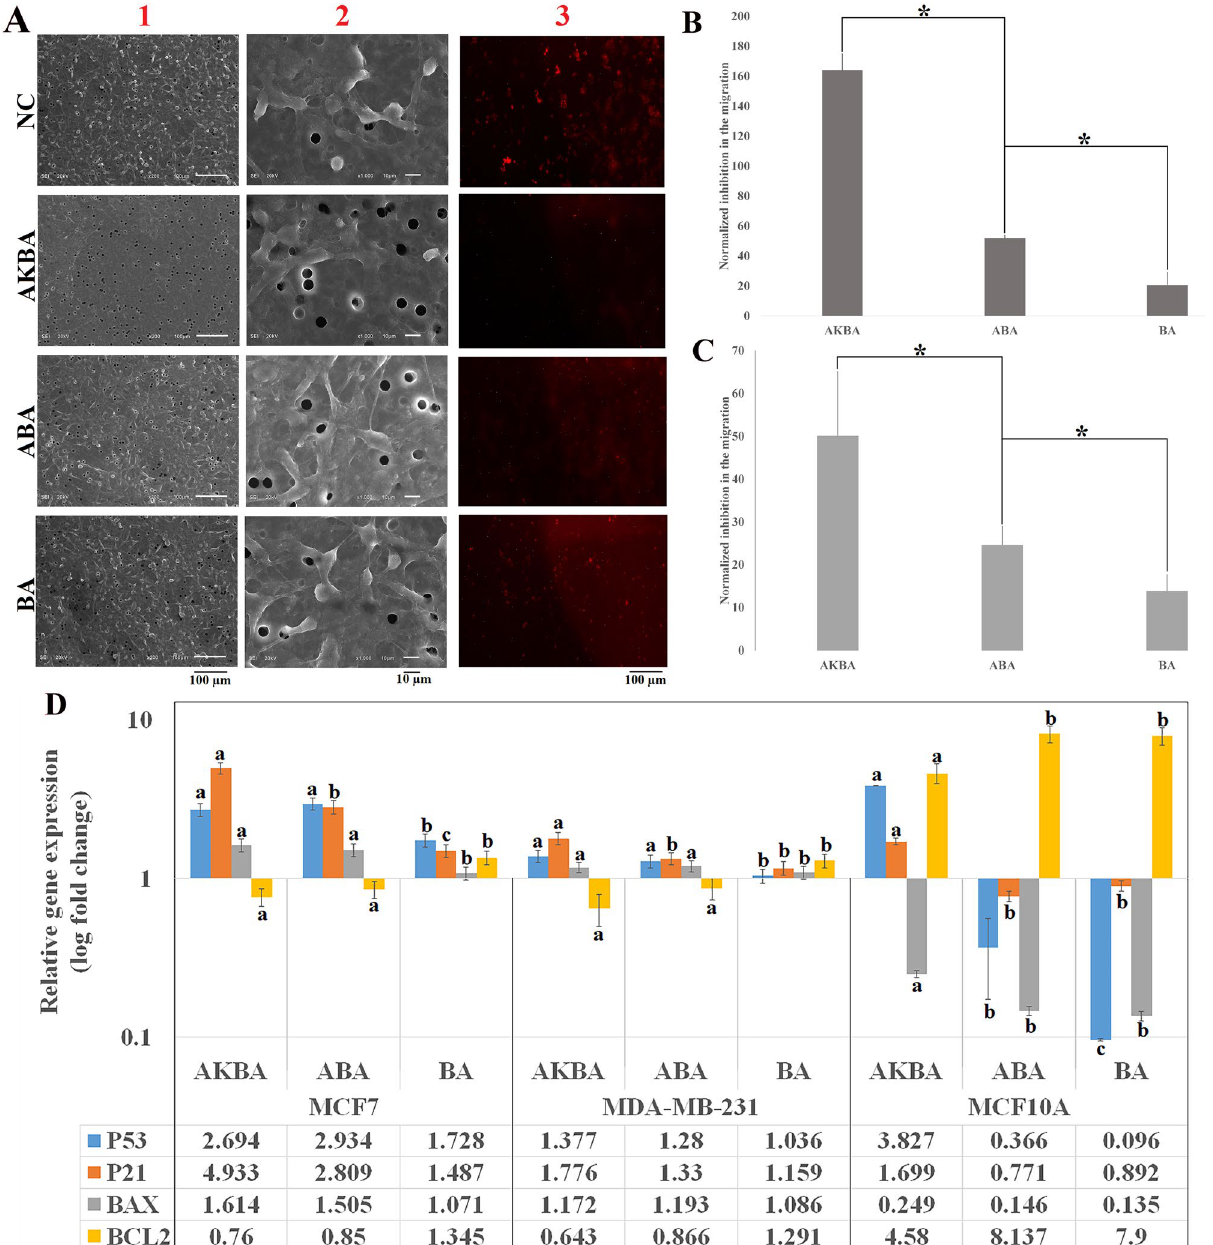
Figure 4. Transwell migration assay. ( A1, 2 ) SEM photos from the migrated MDA-MB-231 cells from the lower side of the transwell membrane. These photos (200X, and 1000X) were taken 48 h after treatment the cells with AKBA, ABA, BA, and negative control (NC). ( A3 ) Fluorescent imaging of red-labeled MDA-MB-231 cells that migrated to the lower side of the membrane. ( B ) Normalized inhibition in MDA-MB-231 cells migration obtained from quantitative analysis of SEM photos. *indicates a significant difference (P < 0.05) (N value = 3). ( C ) Normalized migration inhibition compared to the negative control, as obtained from the quantitative analysis of red-labeled cell migration (n = 3). ( D ) Relative gene expression of P53 , P21 , BAX , and BCL2 genes in MCF-7, MDA-MB-231, and MCF-10A cells after 24 h treatment with AKBA, ABA, and BA in comparison with the negative control. a, b, c, and d revealed different significant levels in each gene (N value =